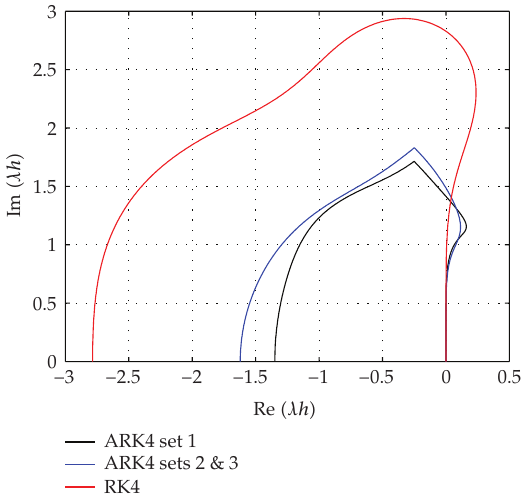
Figure 16: Stability region of ARK4 sets of Table 2 and RK4 set of Table